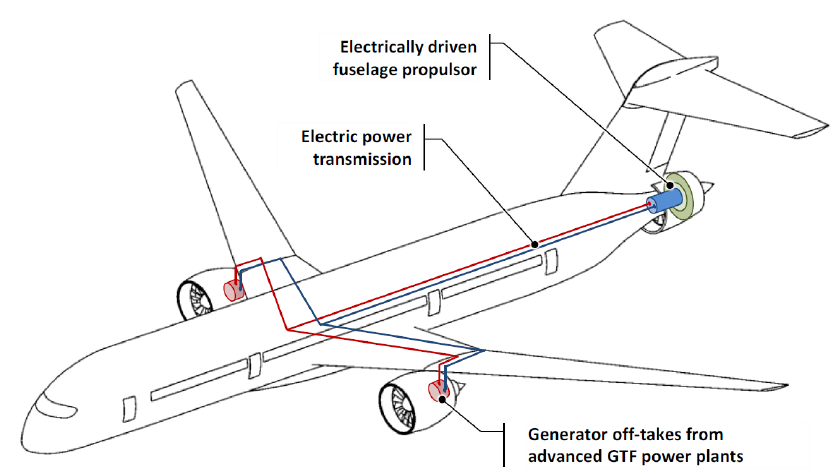
Figure 1. H2020 CENTRELINE architecture (turbo-electrically driven fuselage wake-filling) [18].